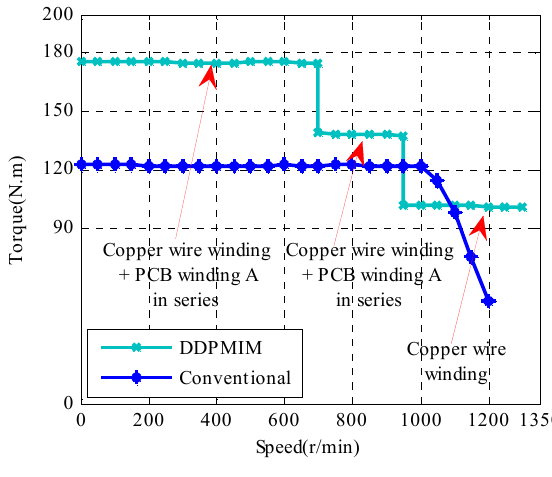
Figure 14. Torque-speed curves.